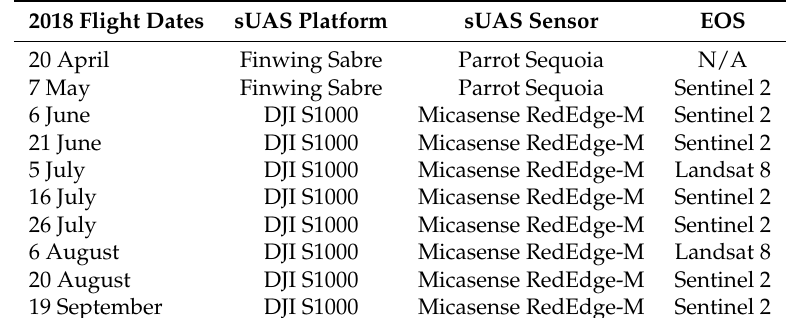
Table 1. Flight dates and platforms.